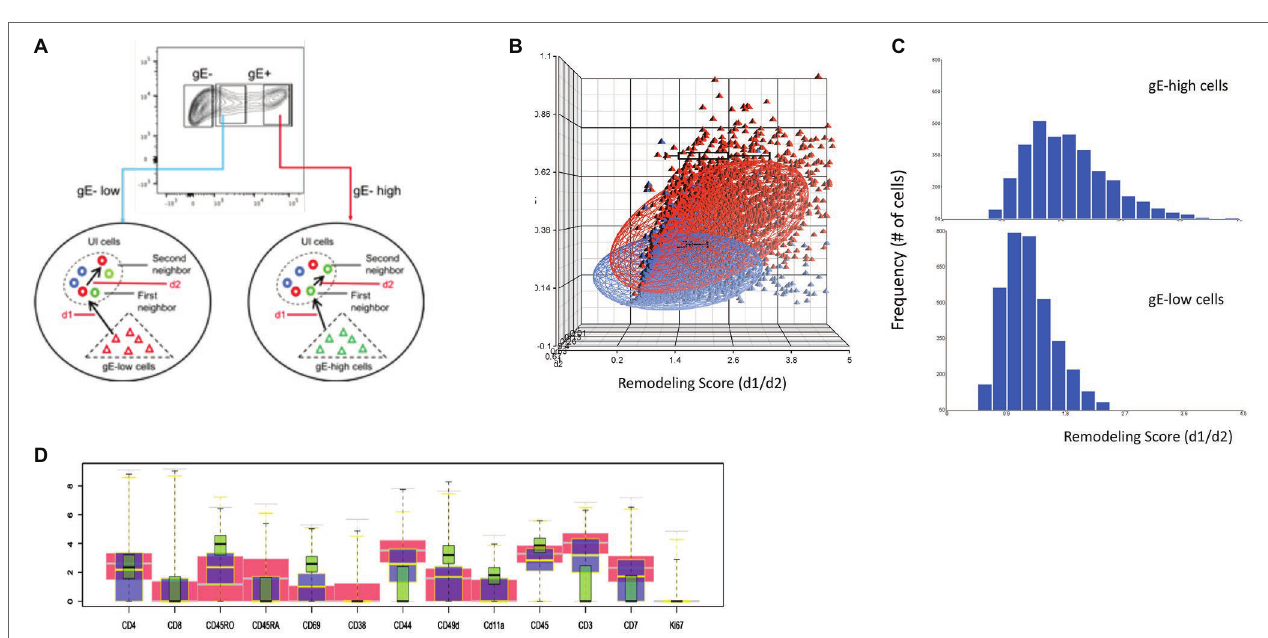
FIGURE 6 | Single cell linkage using distance estimation. (A) Schematic representation of the two-step nearest neighbor analysis for single cell linkage distance estimation (SLIDE) in gE-low and gE-high expressing VZV-infected cells. Each VZV-infected T cell was matched with every mock-infected T cell to identify its closest neighbor based on combinatorial expression of 13 non-core surface markers and the absolute distance (d) between the two cells were recorded as d1. The nearest neighbor mock-infected T cell identified by d1 was subsequently matched to a second nearest neighbor in the same mock-infected population and the distance between the two mock-infected T cells was measured as d2. The remodeling score was estimated by calculating the d1:d2 ratio. (B) Three-dimensional scatterplot of d1, d2, and d1:d2 ratio for each VZV-infected cell. The blue dots are cells that express low gE while the red dots are those that express high-gE. The remodeling score (d1:d2 ratio) is shown in the x-axis; d1 is plotted on y axis while d2 is plotted on z-axis. (C) Histogram analysis showing the frequency of cells for the spectrum of remodeling score calculated for the gE-low and gE-high cells. (D) The box plots show the differential expression of the individual surface proteins between the mock-infected (red) and VZV-infected cells expressing low (blue)- and high (green)-gE.